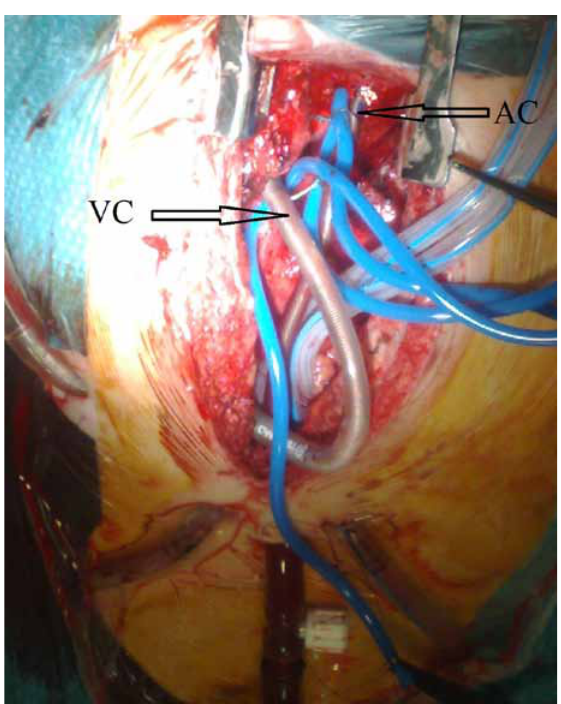
Figure 1. The moment of PediVAS initiation showing arterial cannula inserted into aorta and venous cannulla placed in the dome of common atrium. VA – venous cannula, AC – arterial cannula.